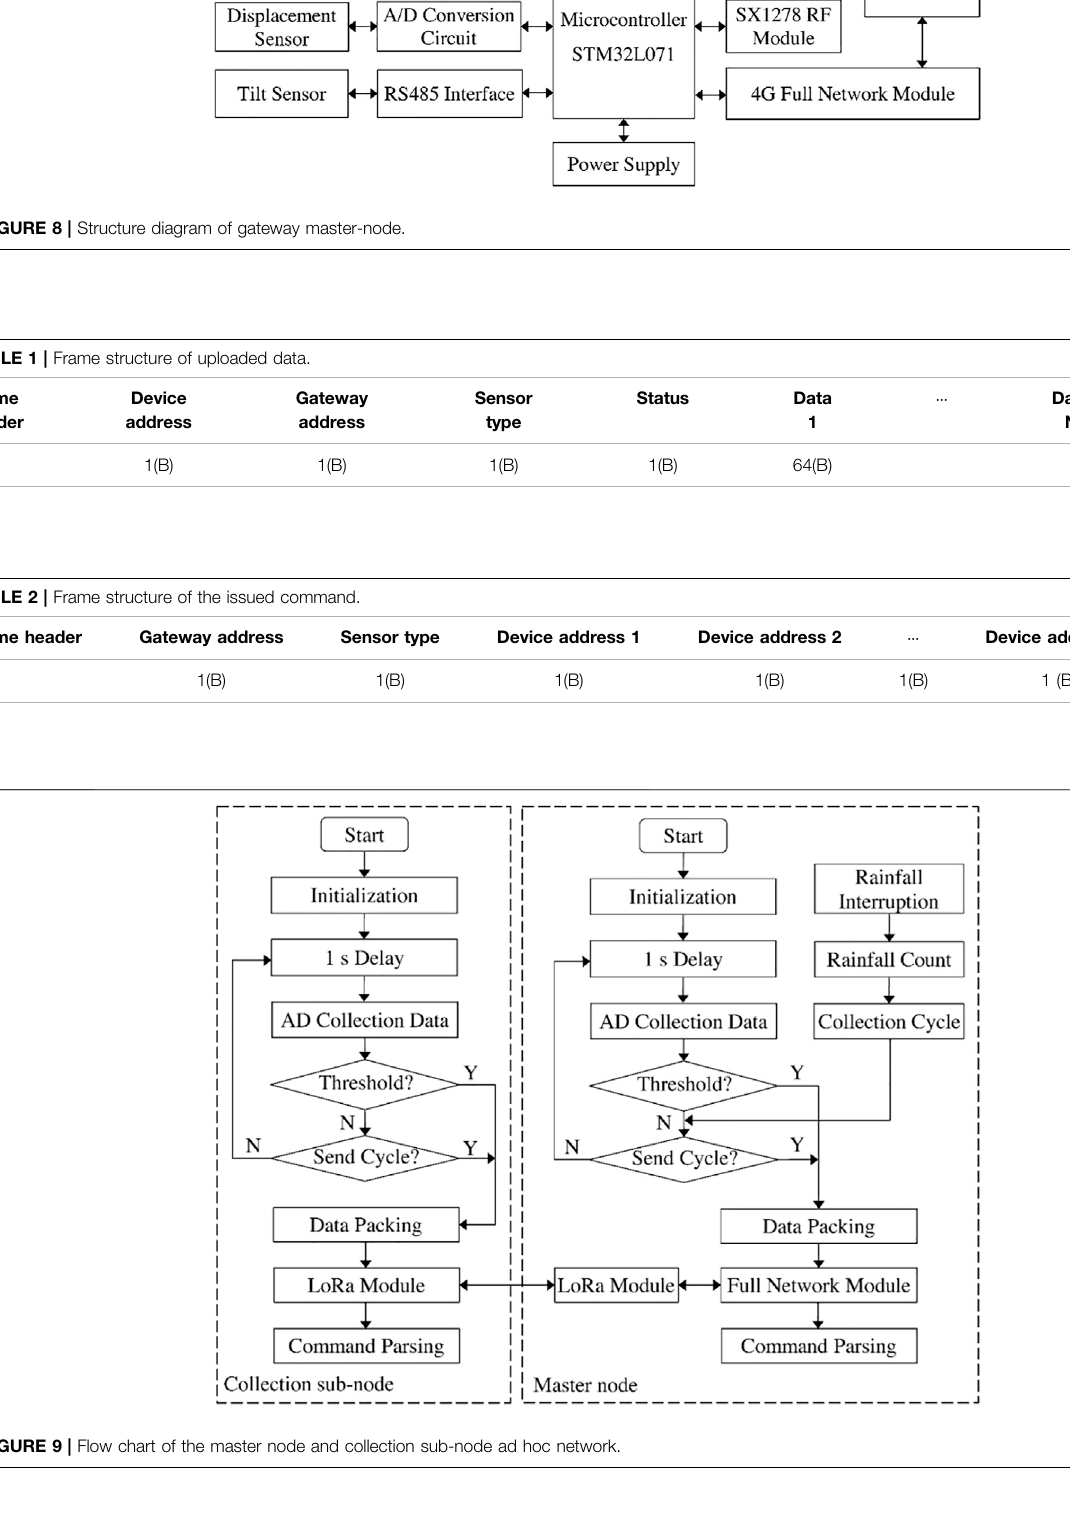
Frontiers in Earth Science |